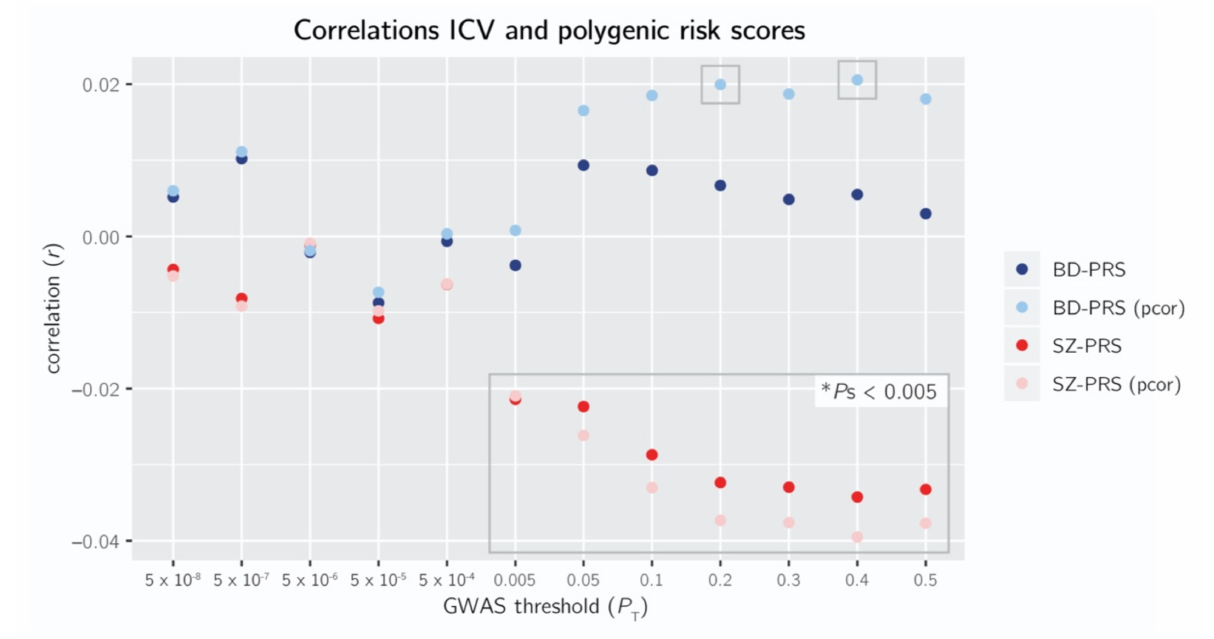
Figure 1. Pearson and partial correlations (pcor) of intracranial volume (ICV) with the polygenic scores of schizophrenia (SZ-PRS) and bipolar disorder (BD-PRS) at 12 genome wide association study (GWAS) P -value thresholds ( P T ): 5 × 10 − 8 , 5 × 10 − 7 , 5 × 10 − 6 , 5 × 10 − 5 , 5 × 10 − 4 , 0.005, 0.05, 0.1, 0.2, 0.3, 0.4, 0.5. Gray boxes: p <